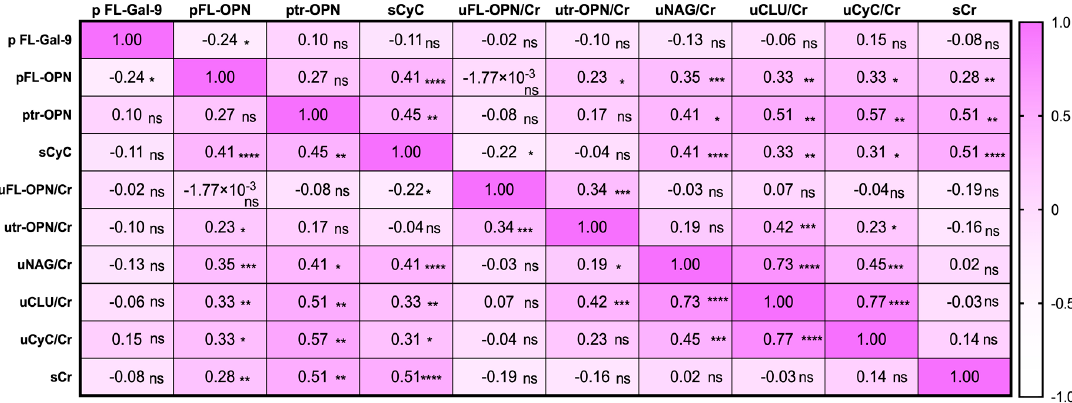
Figure 4. Heatmap of correlation matrix of plasma (p), serum (s) or urinary (u) markers in leptospirosis patients. The correlation was measured by Spearman t test. The correlation r value is written in each well and displayed as colors ranging from white to pink as shown in legend key. p value is written as: ns, no significant; * p < 0.05, ** p < 0.01, *** p < 0.001, **** p < 0.0001. FL-Gal-9, galectin-9; FL-OPN, full length of osteopontin; tr-OPN, thrombin –cleaved osteopontin; NAG, N -acetyl- β - D -glucosidase, CLU, clusterin; CyC, cystatin C; Cr, creatinine.